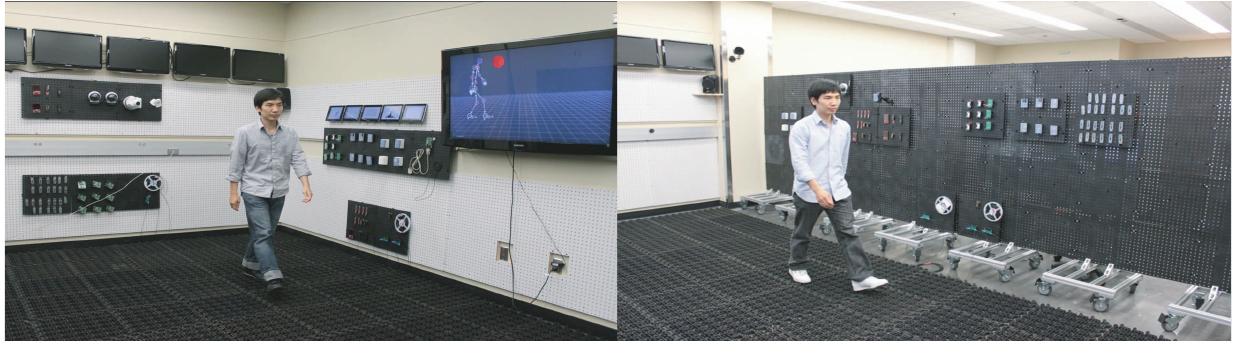
Figure 27. A testbed for MAS-based smart house